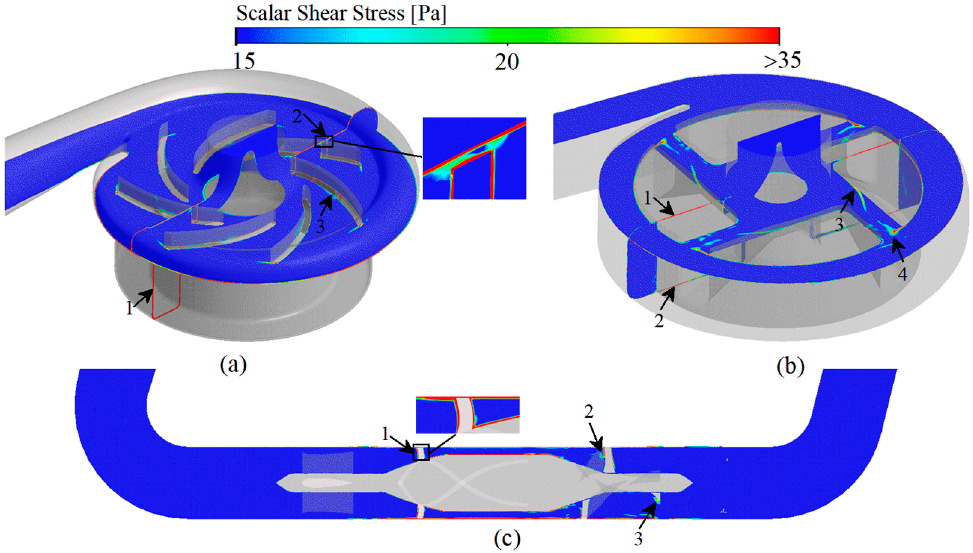
Figure 7. Scalar shear stress prediction of three studied VADs: ( a ) CH-VAD; (b) HVAD; ( c )